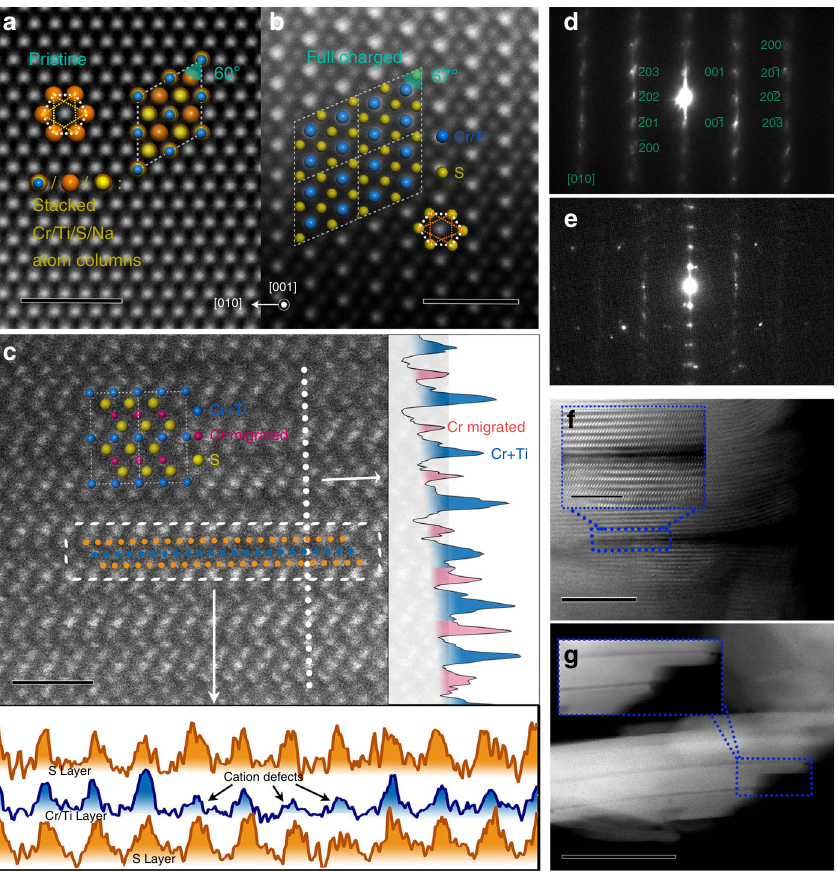
Fig. 5 Characterization of full charged O1 ′ NaCr 2/3 Ti 1/3 S 2 and after cycling. STEM image of a , the pristine NaCr 2/3 Ti 1/3 S 2 particle along c -axis, scale bar 1 nm. b the full charged Na 0 Cr 2/3 Ti 1/3 S 2 particle along c -axis, scale bar 1 nm. c The full charged Na 0 Cr 2/3 Ti 1/3 S 2 particle along a / b- axis, scale bar 1 nm. d SAED pattern of full charged Na 0 Cr 2/3 Ti 1/3 S 2 particle along [010]-axis. e SAED pattern of discharged sample after 10 cycles. f First one-third charged Na 0.66 Cr 2/3 Ti 1/3 S 2 along a / b- axis, scale bar 10 nm, inset scale bar 5 nm. g Discharged sample after 10 cycles along a / b- axis, scale bar 100